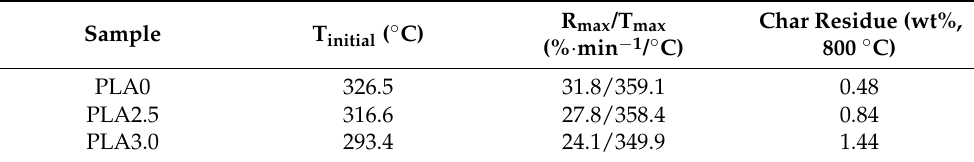
Figure 3. ( a ) TG and ( b ) DTG curves of PLA/MKF/NTPA biocomposites under N 2 . Table 3. Thermal degradation data of PLA/MKF/NTPA